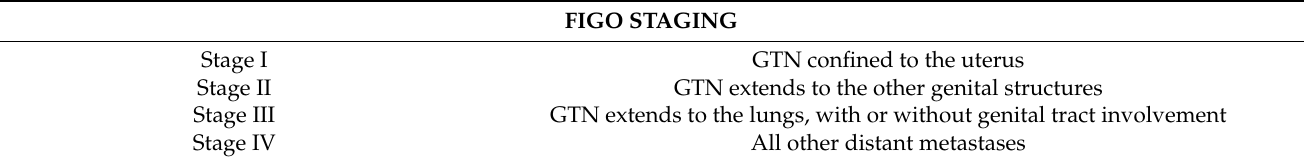
Table 2. FIGO score, 2000 scoring system.